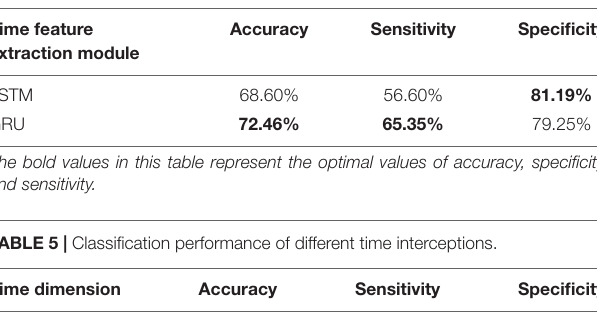
The bold values in this table represent the optimal values of accuracy, specificity and sensitivity. TABLE 4 | Performance of different temporal feature extraction modules.